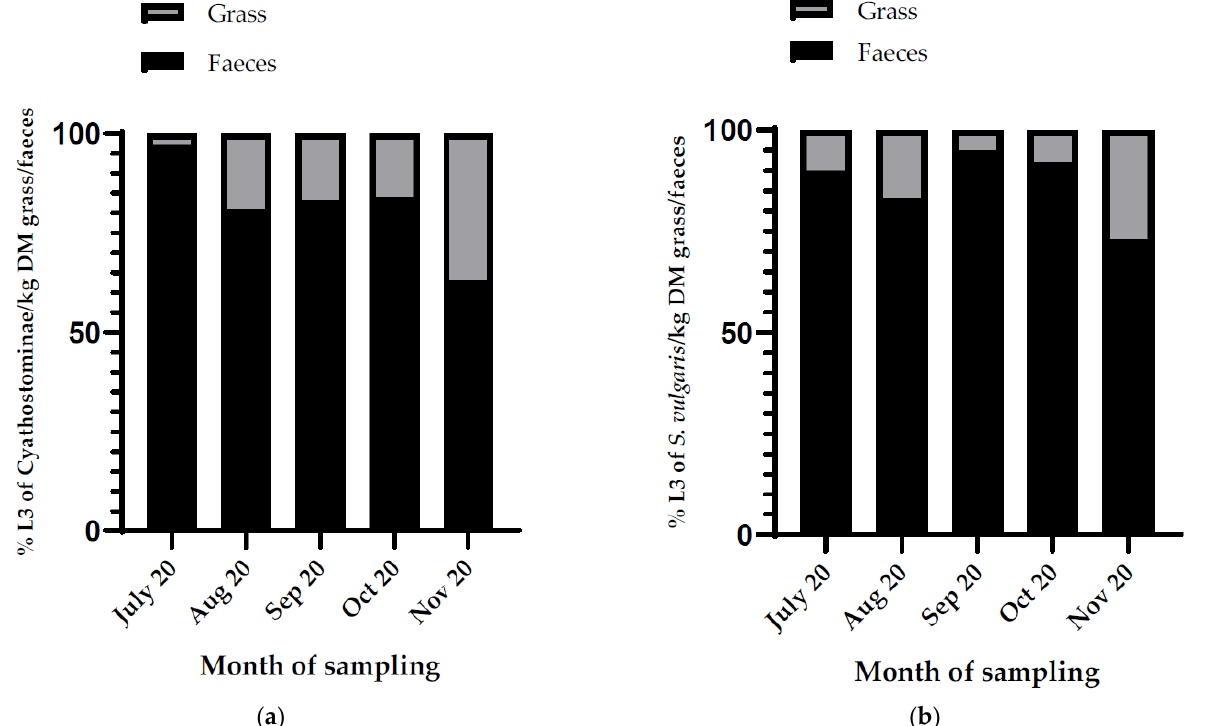
Figure 11. Graph showing the proportion (in %) of: ( a ) Cyathostominae larvae (L3) per kg DM faeces and grass and ( b ) S. vulgaris larvae (L3) per kg DM faeces and grass during the first five months of the overwintering study.